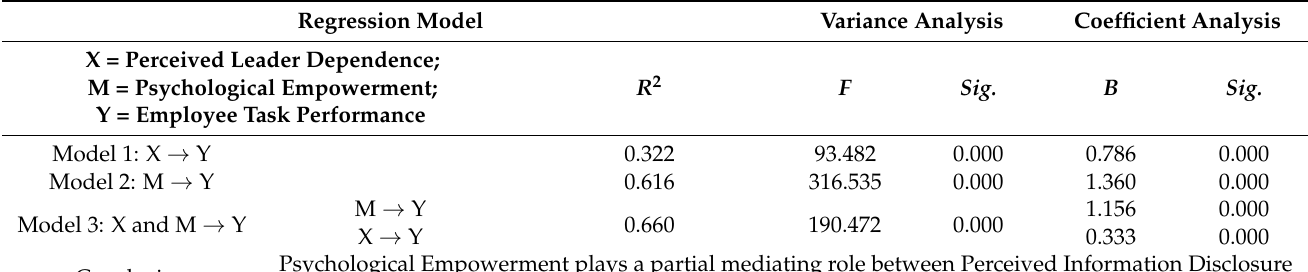
Table 24. Test of the Mediating Effect of Psychological Empowerment between Perceived Information Disclosure and Employee Task Performance.